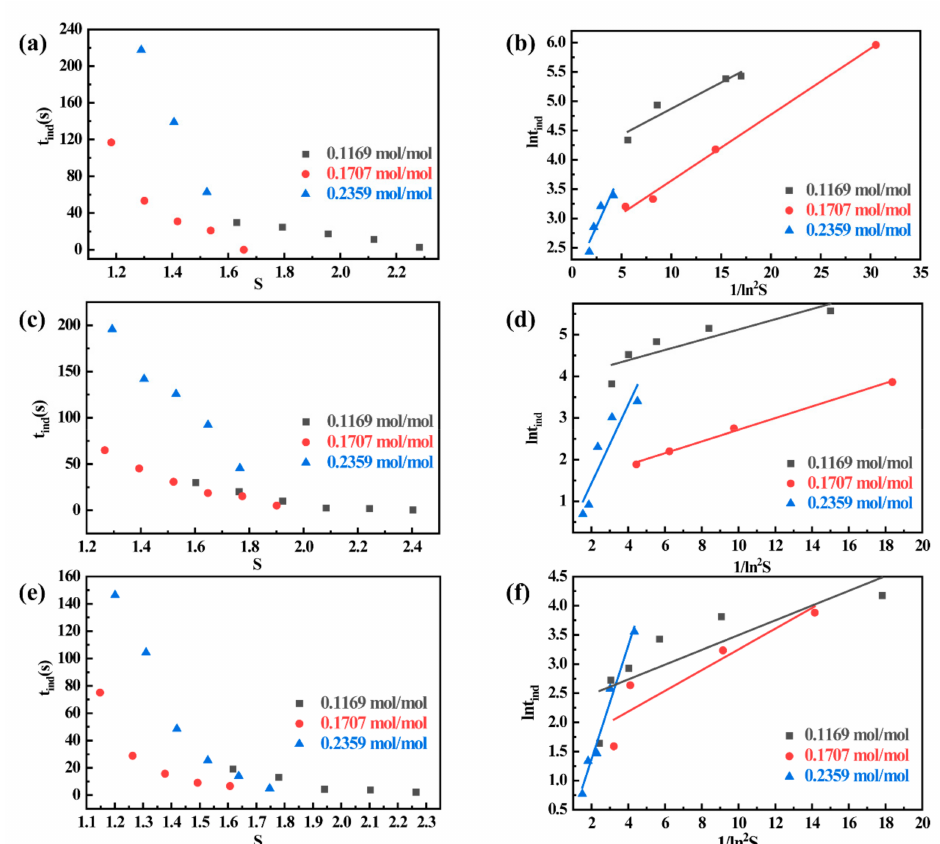
Figure 2. ( a ) Relationship between supersaturation and induction period at different